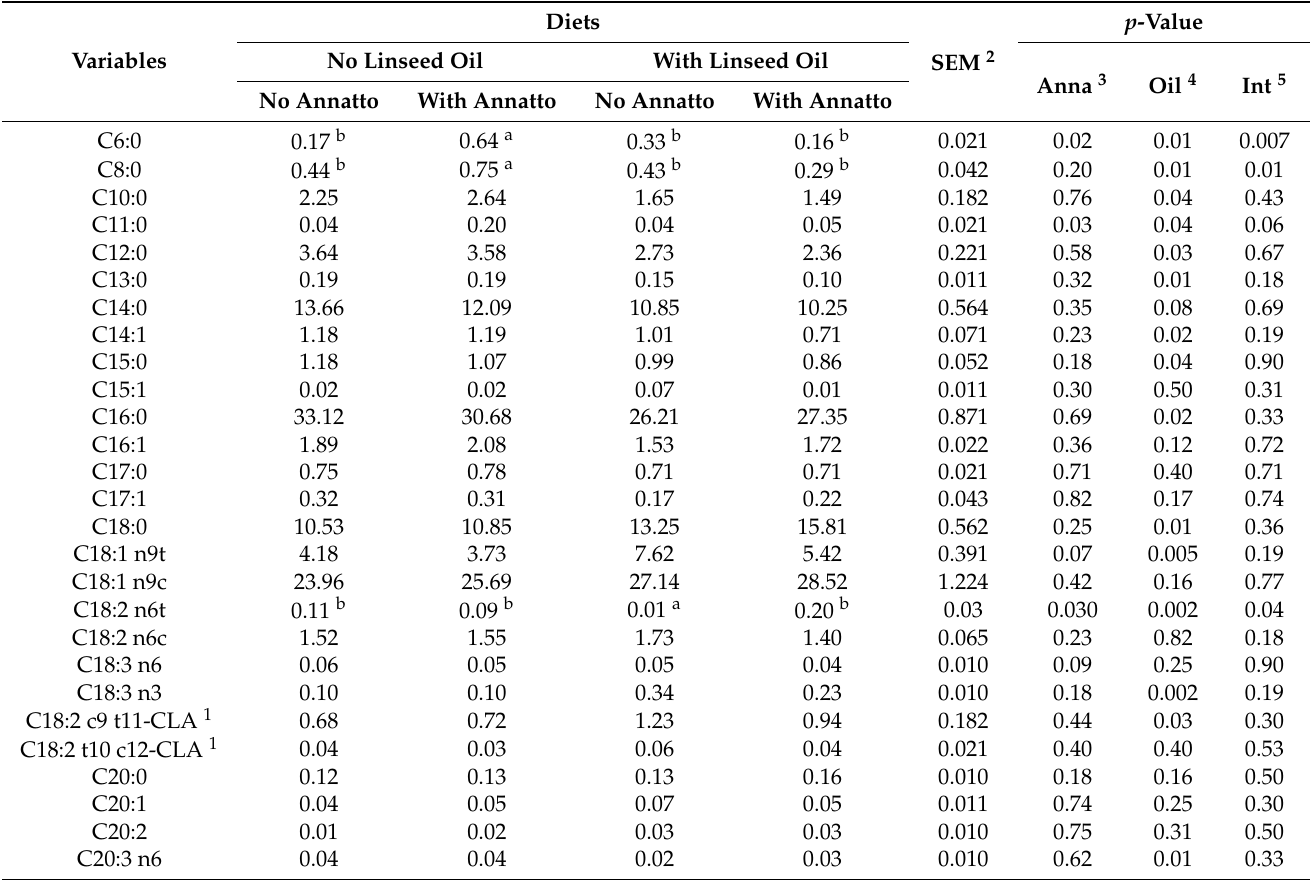
Table 4. Composition of fatty acids in milk (g/100 g of total lipids) of Holstein cows fed annatto seeds and linseed